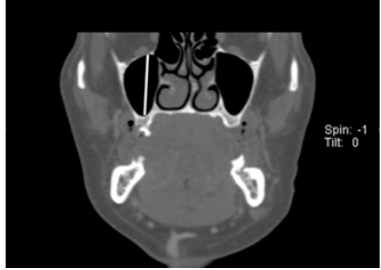
Fig.2: vertical line denotes the height of maxillary